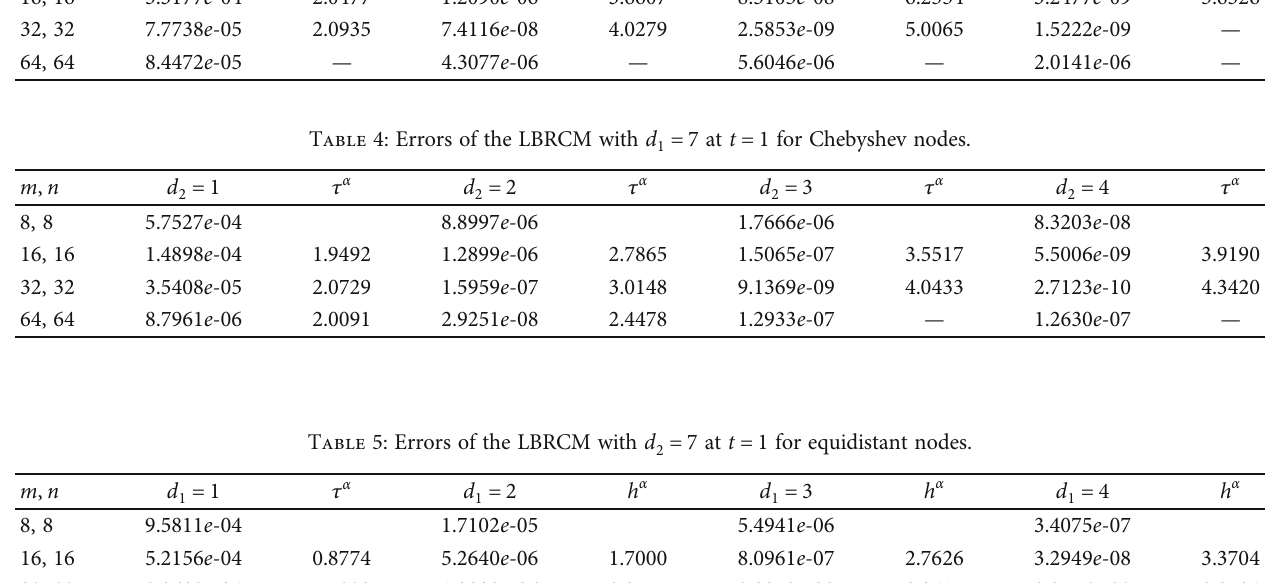
Table 3: Errors of the LBRCM with d